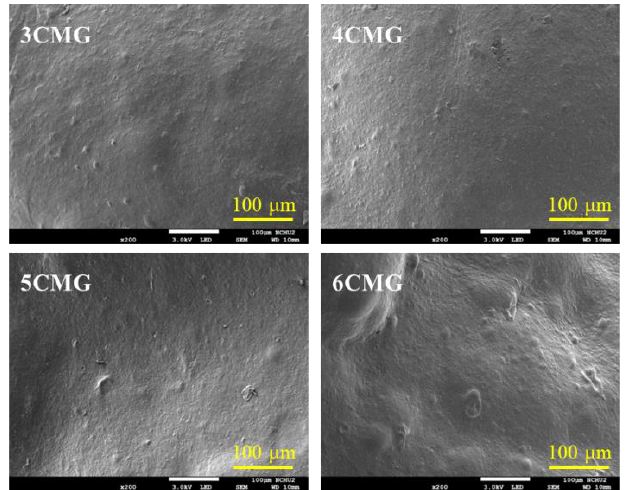
Figure 3. SEM micrographs of various CMG hybrid